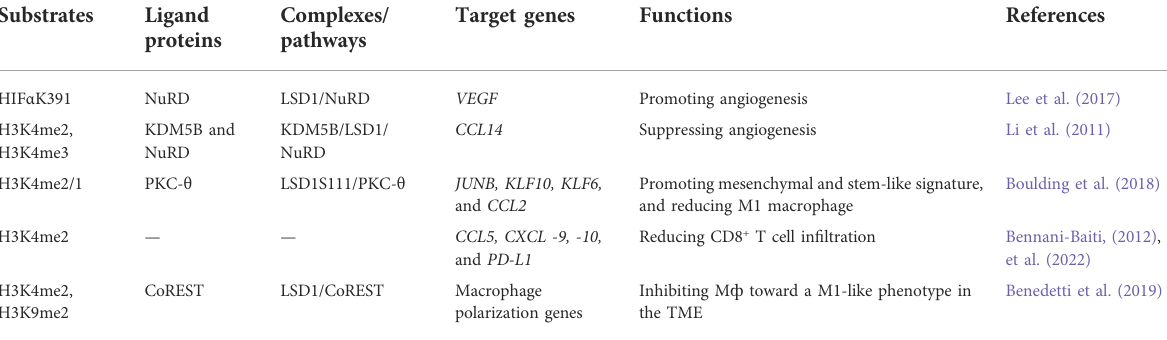
TABLE 2 Regulatory roles of LSD1 in BC angiogenesis and microenvironment.